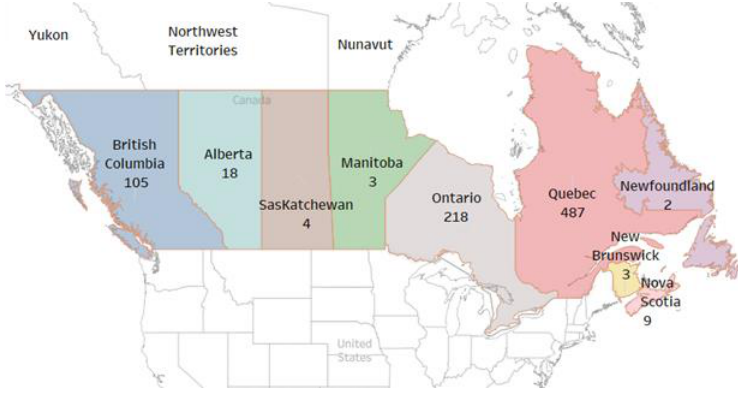
Figure 4. Number and distribution of EVs used in this project.